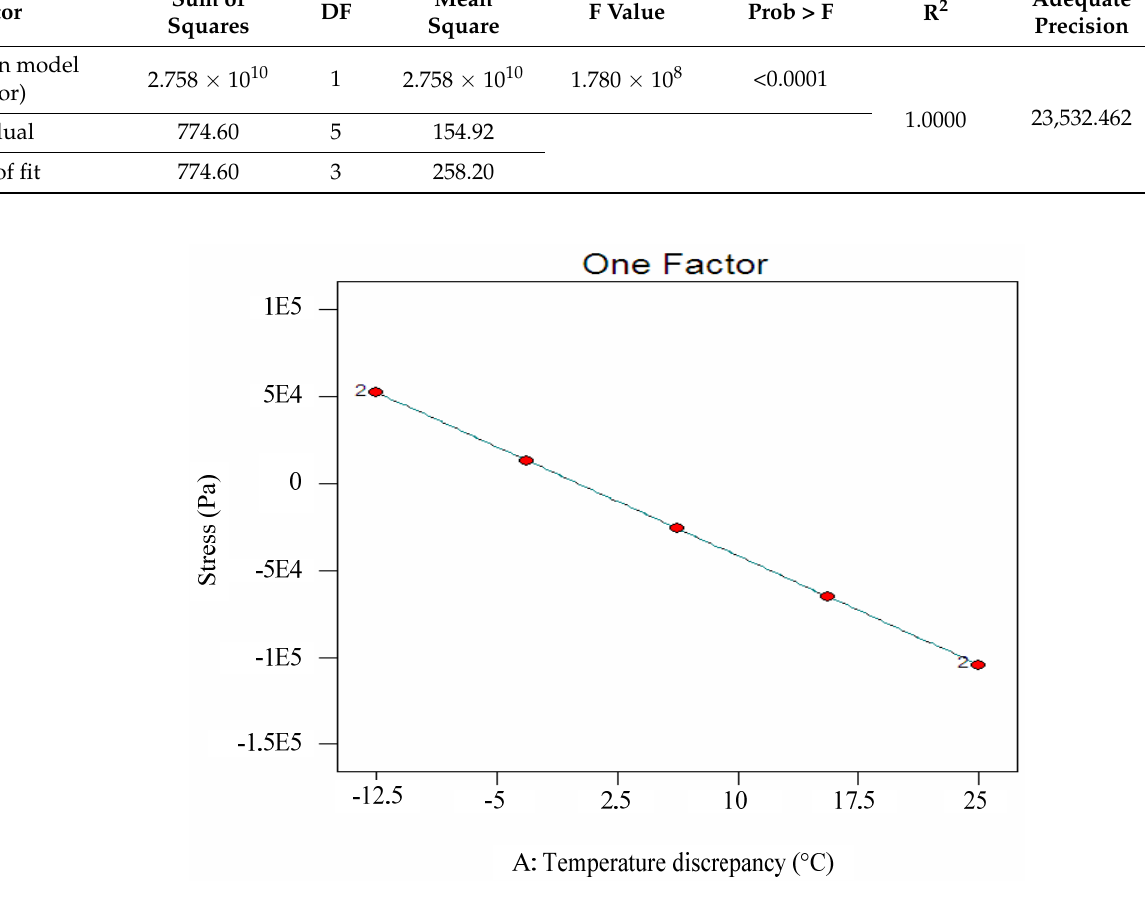
Figure 7. Temperature discrepancy–stress plot.